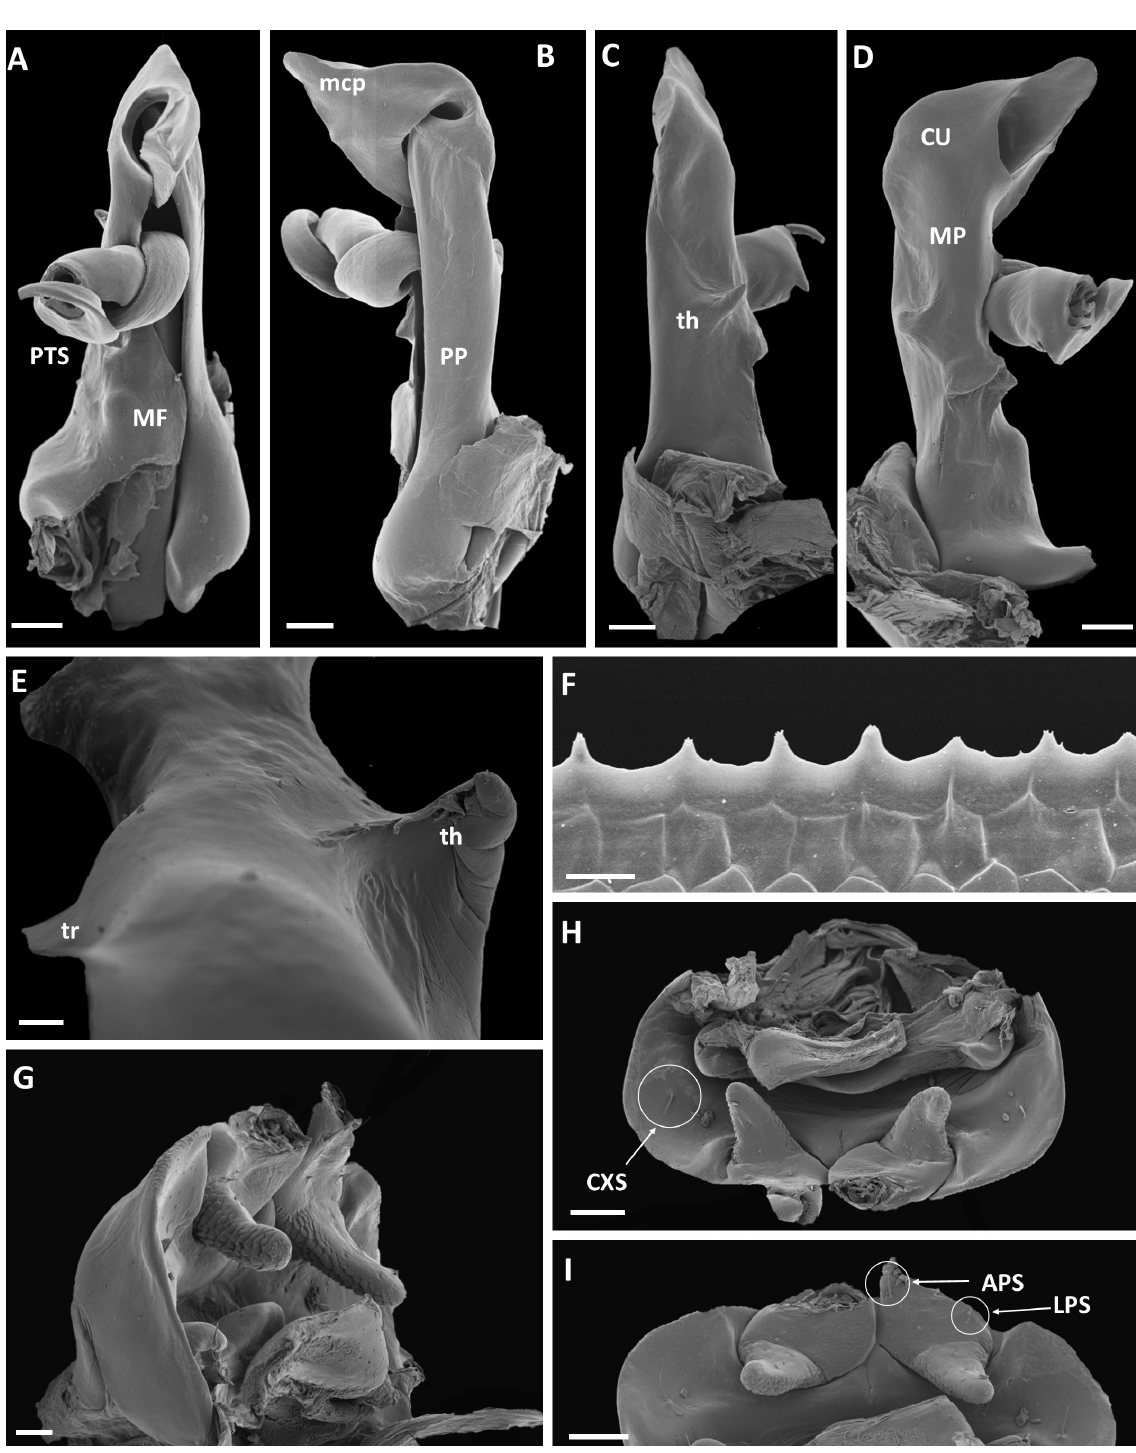
Fig. 56. Syndesmogenus estelleae sp. nov., holotype, ♂ (NHMO). A–E . Right gonopod coxa and basomere. A. Mesal view. B. Anterior view. C. Lateral view. D. Posterior view. E. Oblique lateroposterior view. F . Midbody dorsal limbus. G–I . First pair of legs (only coxosternum and prefemora). G. Sublateral view. H. Ventral view. I. Anterior view. Abbreviations: APS = mesapical prefemoral seta; CXS = coxosternal seta; CU = cucullus; LPS = lateral prefemoral setae; mcp = mesal cucullar process; MF = metaplical flange; MP = metaplica; PP = proplica; PTS = port-torsal spine; th = thumblike process; tr = triangular process. Scale bars: A–D, H–I = 0.1 mm; E = 0.02 mm; F = 0.01 mm; G = 0.05